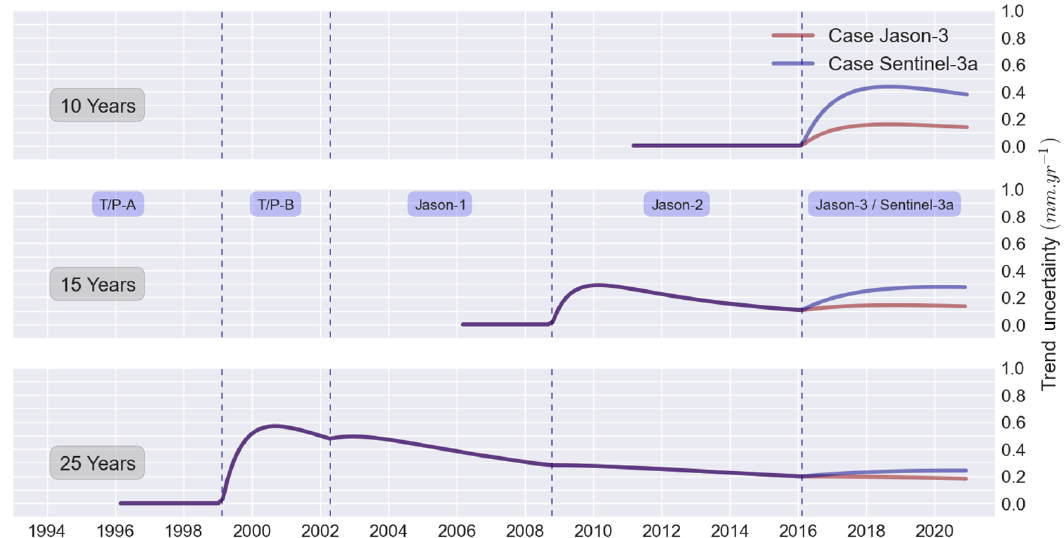
Figure 1. Impact of global mean sea level inter-mission linking bias uncertainties on the estimation of the MSL trend over 10 years (upper panel), 15 years (middle panel), and 25 years (lower panel), in the cases of Jason-3 and Sentinel-3a.